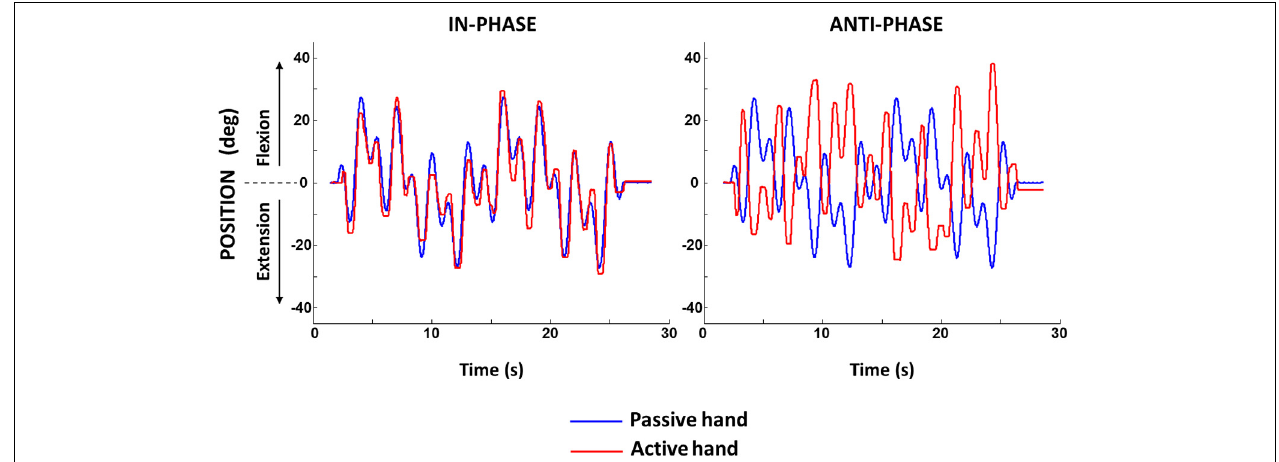
FIGURE 1 | Sample of motor-generated motion in the passive hand and tracking motion of the active hand for in-phase and anti-phase conditions.